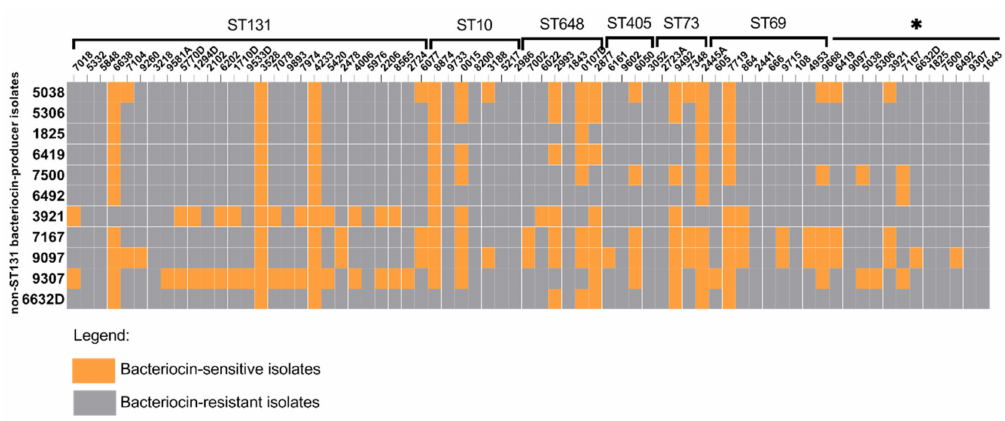
Figure 2. Bacteriocin activity among non-ST131 isolates. The graph shows the bacteriocin activity of non-ST131 isolates against isolates from di ff erent ST types. The * indicates the singleton isolates. Orange represents isolates that were sensitive to the bacteriocin produced by the non-ST131 isolates and grey represents the bacteriocin-resistant isolates. Table 1. Bacterial isolates, their ST types, serotypes and phylogenetic groups. Isolates ID ST